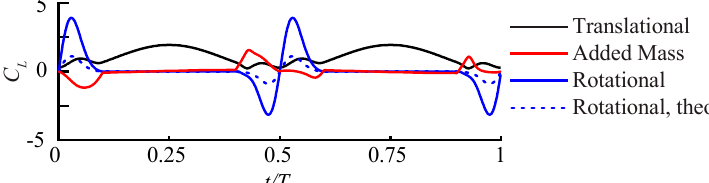
Figure 15. Plots of the translational (black), added mass (red), rotational (blue) and theoretical rotational (blue dashed), added mass and rotational lift forces in the QS model for the largest difference motion. A = 60°, Δ τ r = 0.2, and x pa = 1.0.